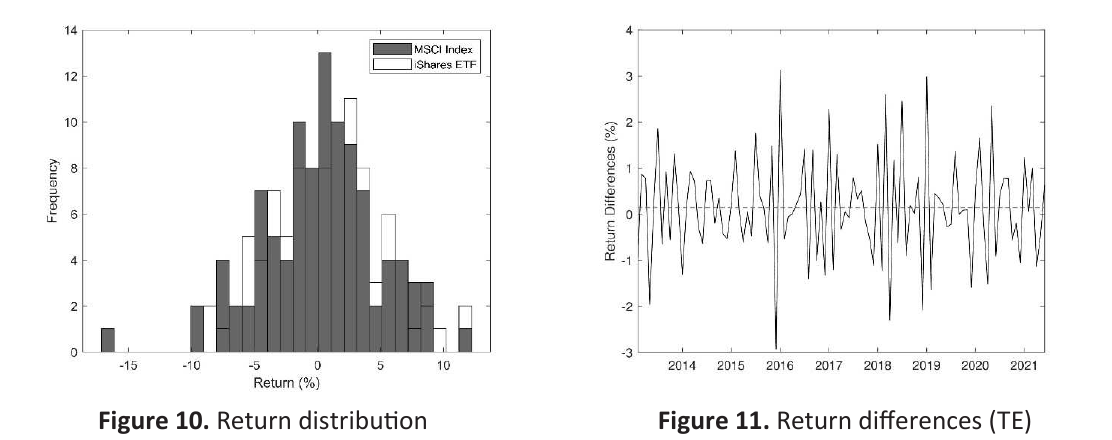
Figure 10. Return distribution of MSCI-EM and EEM